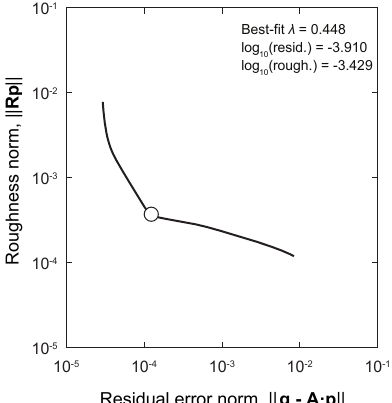
Figure 6. Tikhonov regularization L-curve for Narayani POC ( β = 5 ◦ Cmin − 1 ). The black line represents the range of roughness and residual error norms that are the result of solving Eq. (39) for p using multiple λ values ranging from 0 . 001 to 100. The white circle corresponds to the point of maximum curvature along this line, and is thus deemed the best-fit λ value (see Hansen, 1994, and Forney and Rothman, 2012b, for further details on generating the L-curve and theory behind Tikhonov